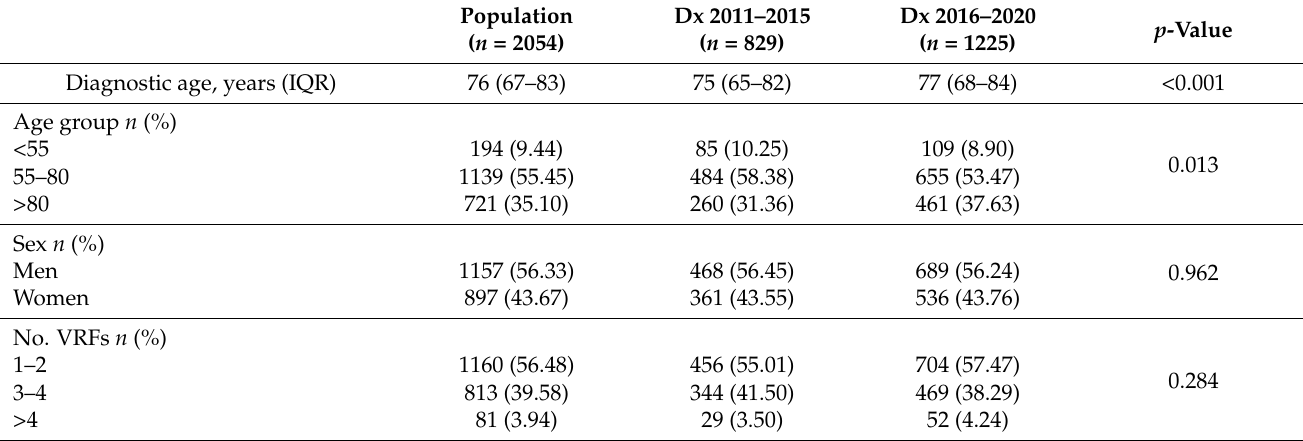
Table 1. Distribution of demographic characteristics and vascular risk factors of patients according to disease in both year